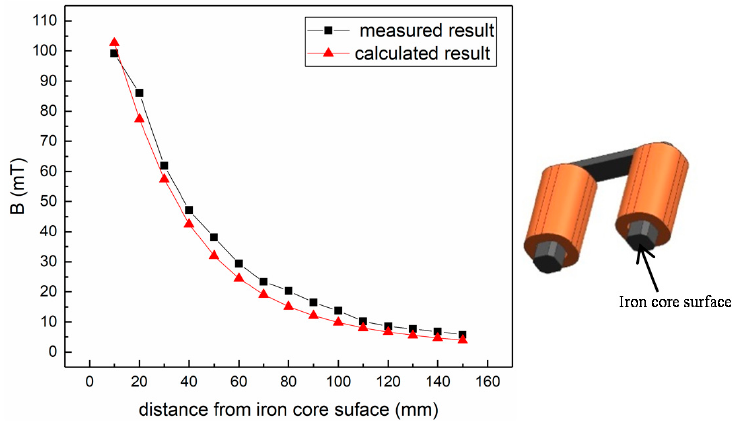
Figure 5. Comparison of the calculated magnetic flux density with the measured values.